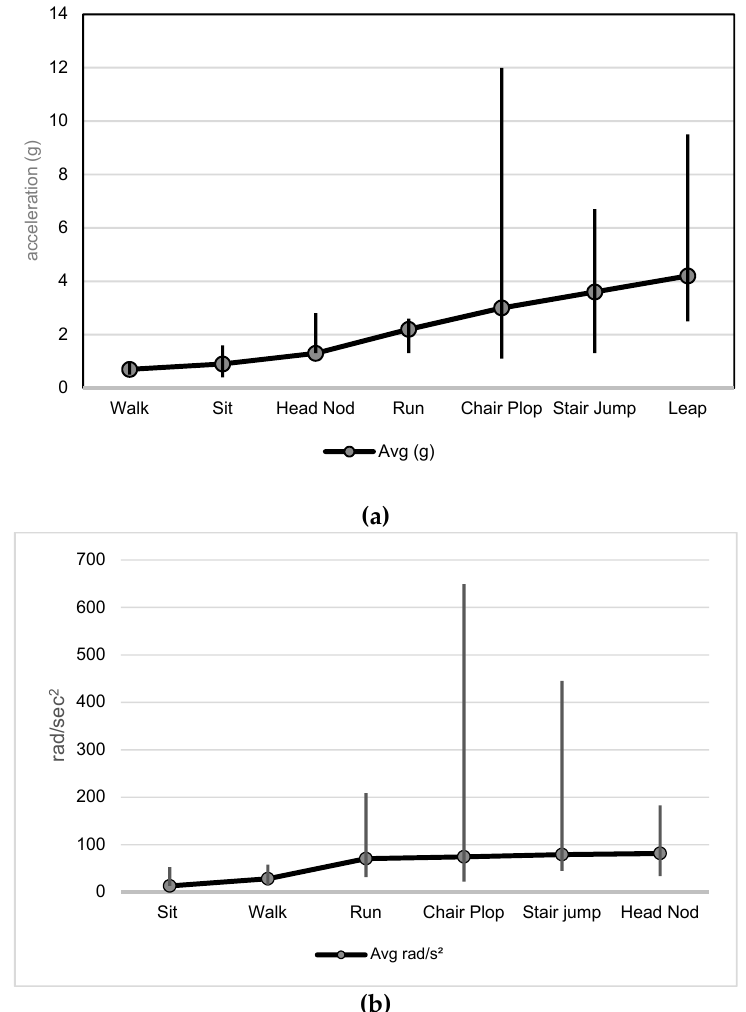
Figure 5. ( a ): Mean and range of peak linear head acceleration (g) measured for 6 ADLs. ADL: activities of daily living; Avg: average linear head acceleration in g. The vertical line illustrates the range of values for each ADL. ( b ) Mean and range of peak angular head acceleration (rad/s 2 ) for 6 selected ADLs. ADL: activities of daily living; Avg: average peak angular acceleration in rad/s 2 . The vertical line illustrates the range of values for each ADL.